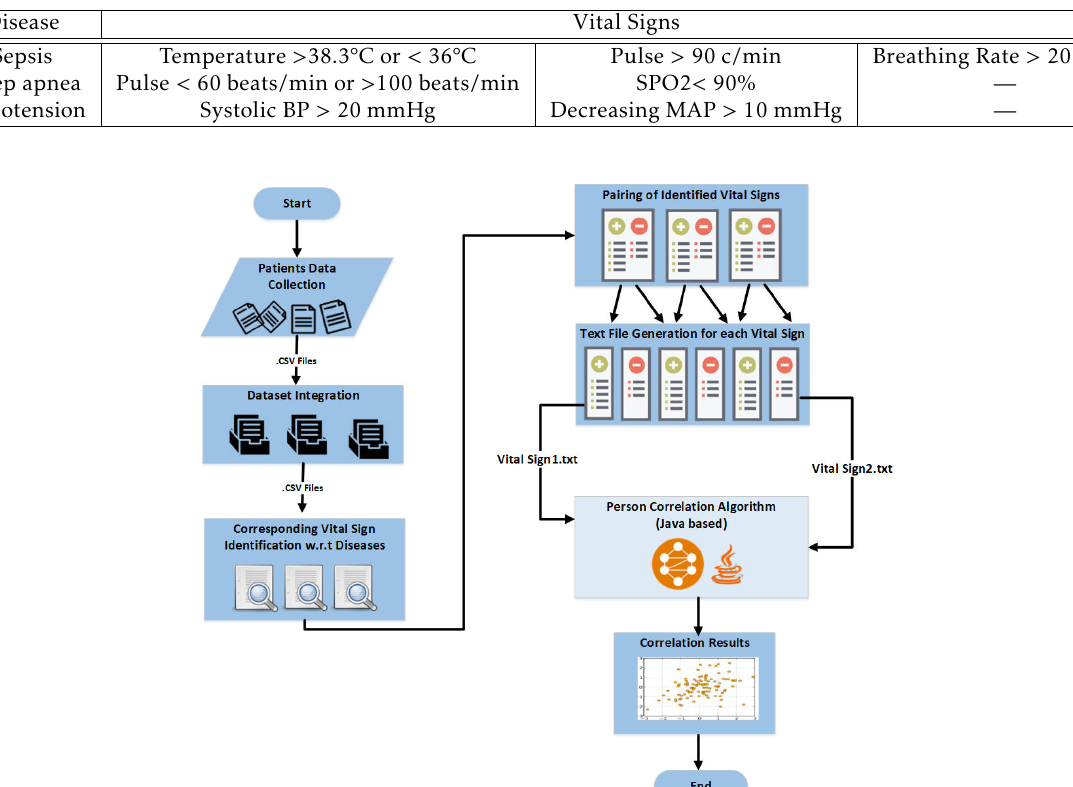
Table 1. Selected Diseases and Corresponding Vital Signs’ Threshold Values